Question: Which kind of chart has been used to present this data?
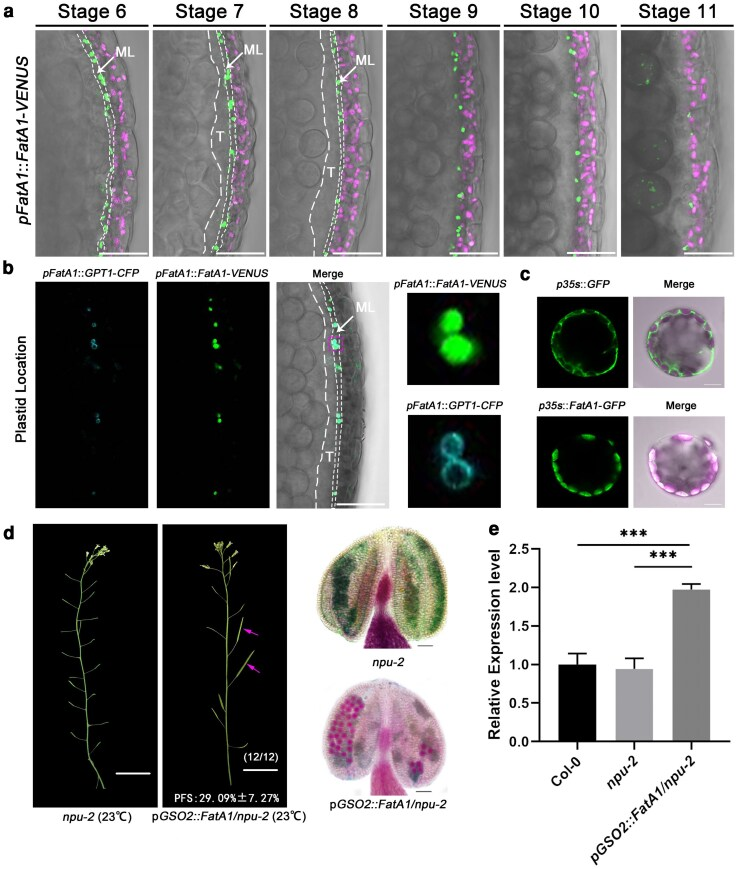
Answer: bar